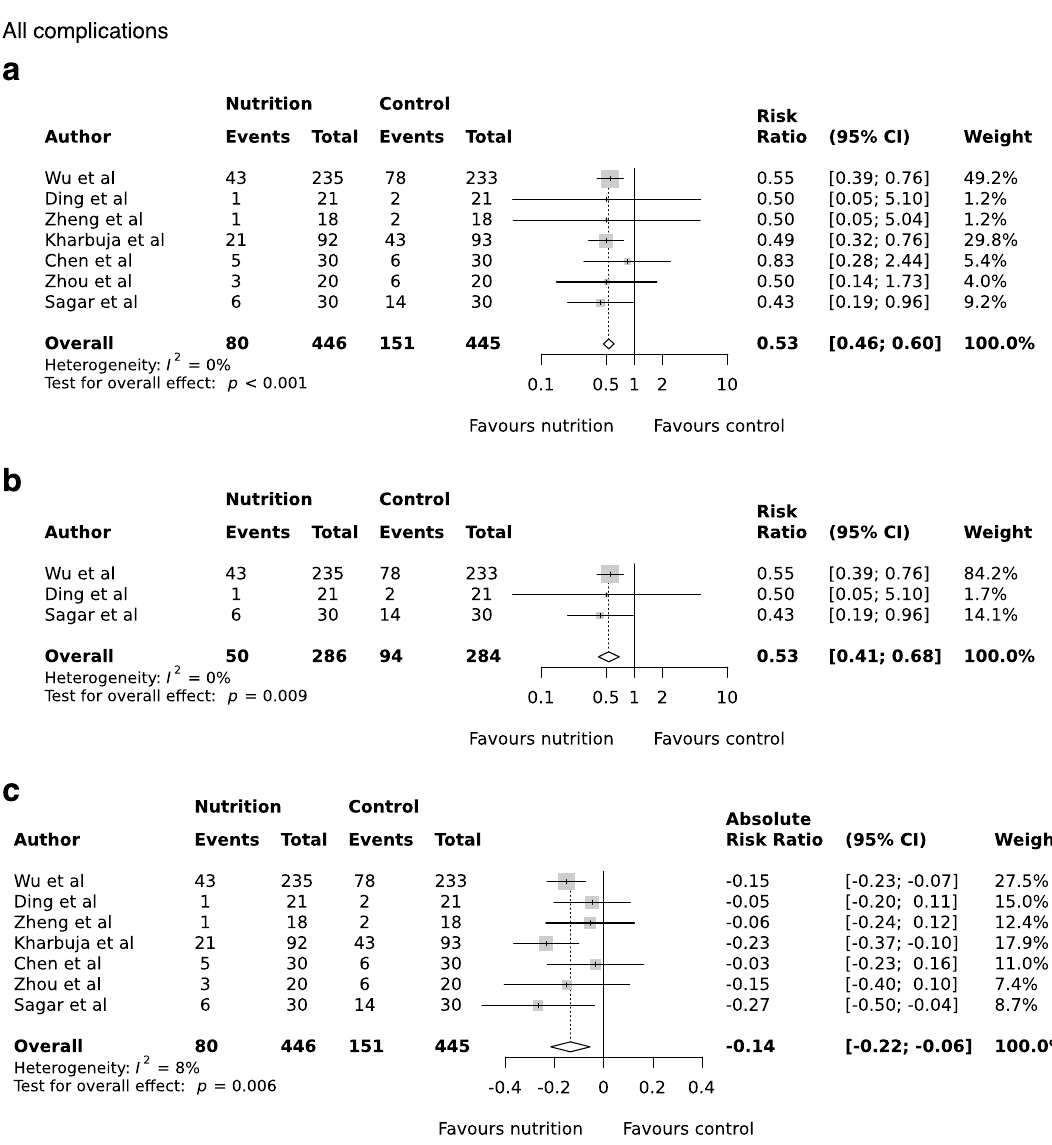
Figure 2. Random-effects meta-analysis of the effects of preoperative oral nutrition on postoperative complications ( a ), when nutritional support was provided for at least 5 days pre-operatively ( b ), and risk difference ( c ) in patients undergoing surgery for gastrointestinal